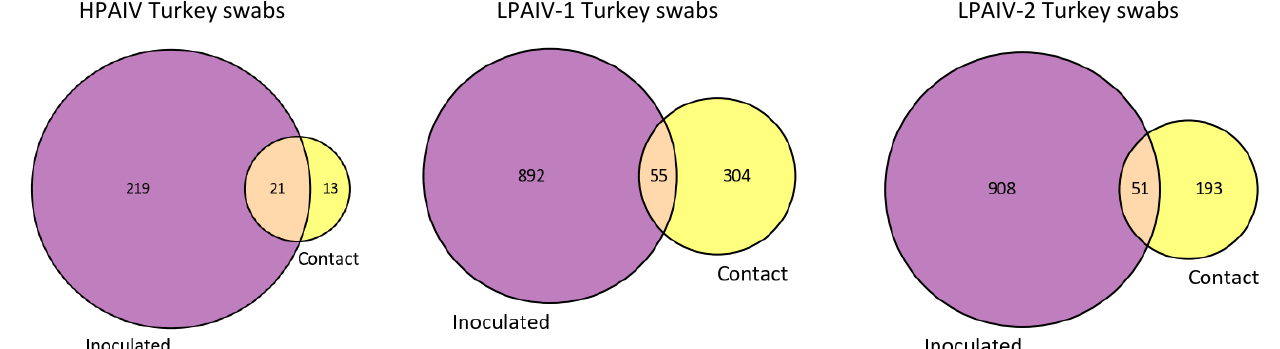
Figure 2. Unique iSNVs from viral genomes sequenced in OP swabs sampled from directly inoculated and contact turkeys. The iSNVs were enumerated and pooled for groups inoculated or contact- exposed with the same virus. The sets of iSNVs were then compared between samples from directly inoculated and contact turkeys.